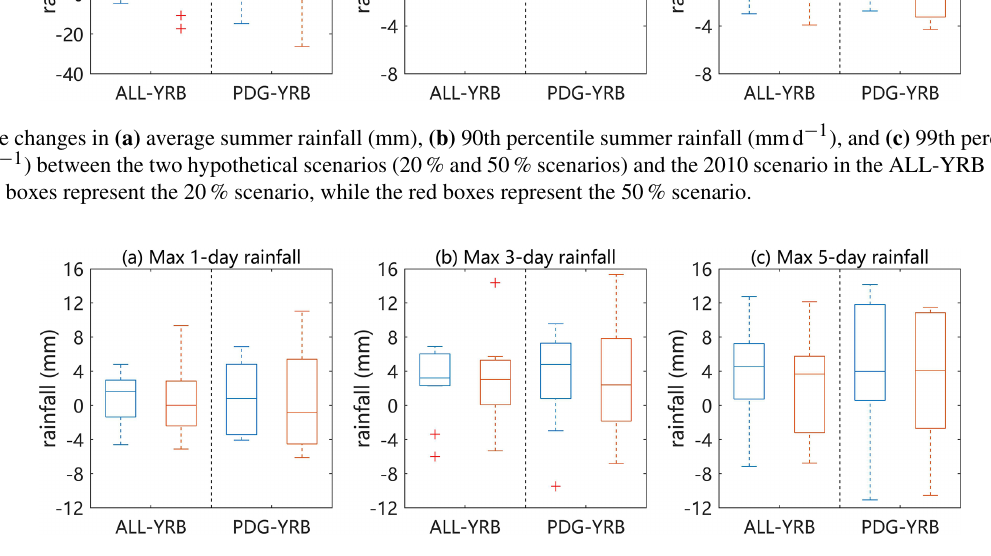
Figure 11. The changes in maximum (a) 1, (b) 3, and (c) 5d rainfall between the two hypothesis scenarios (20% and 50% scenarios) and the 2010 scenario in the ALL-YRB and PDG-YRB area. The blue boxes represent the 20% scenario, while the red boxes represent the 50%